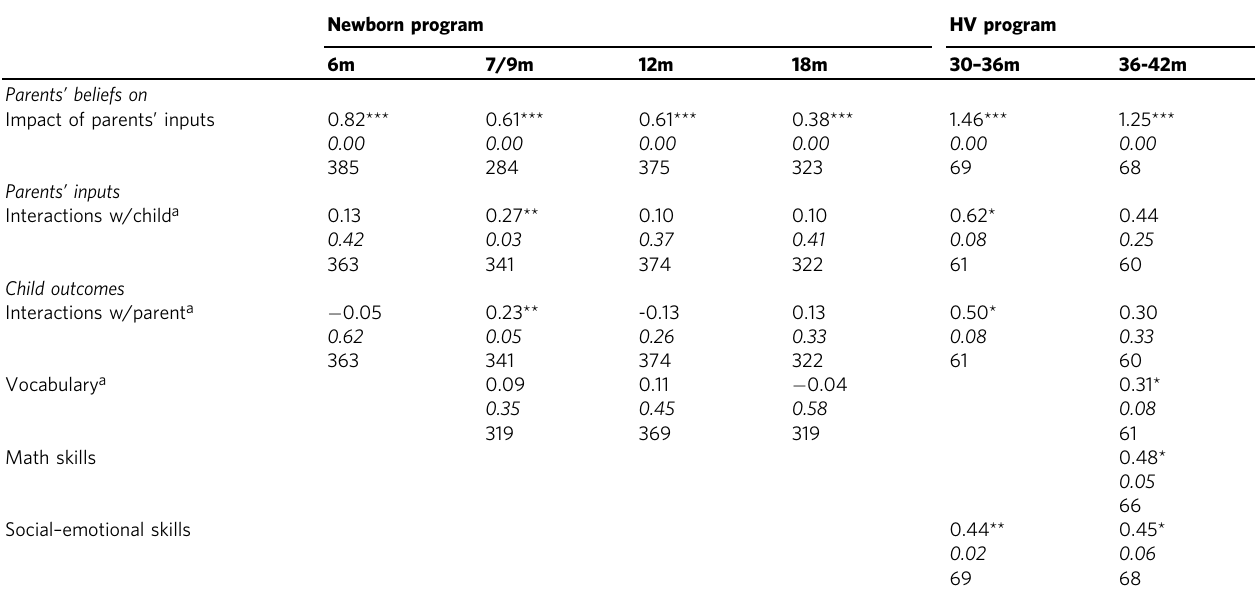
Differences between treatment and control group means are shown fi rst for the two experiments at different time points. Below in italics are the multiplicity-adjusted p -values based on a two-sided Student ’ s t test. The adjustment procedure follows List, Shaikh and Xu (2019). Families of outcomes for the adjustment are described in the Supplementary Information, section 5. Below the p -values is the number of observations used in the regression. *For multiplicity-adjusted p -value<0.1, **for multiplicity-adjusted p -value<0.05, ***for multiplicity-adjusted p -value<0.01. a Signalsthatthe measurementtoolsusedinthetwo experimentsaredifferent(seeSupplementaryInformation,section4).Inthe7/9monthscolumn,beliefsaremeasuredat7months,andinteractions are measured at 9